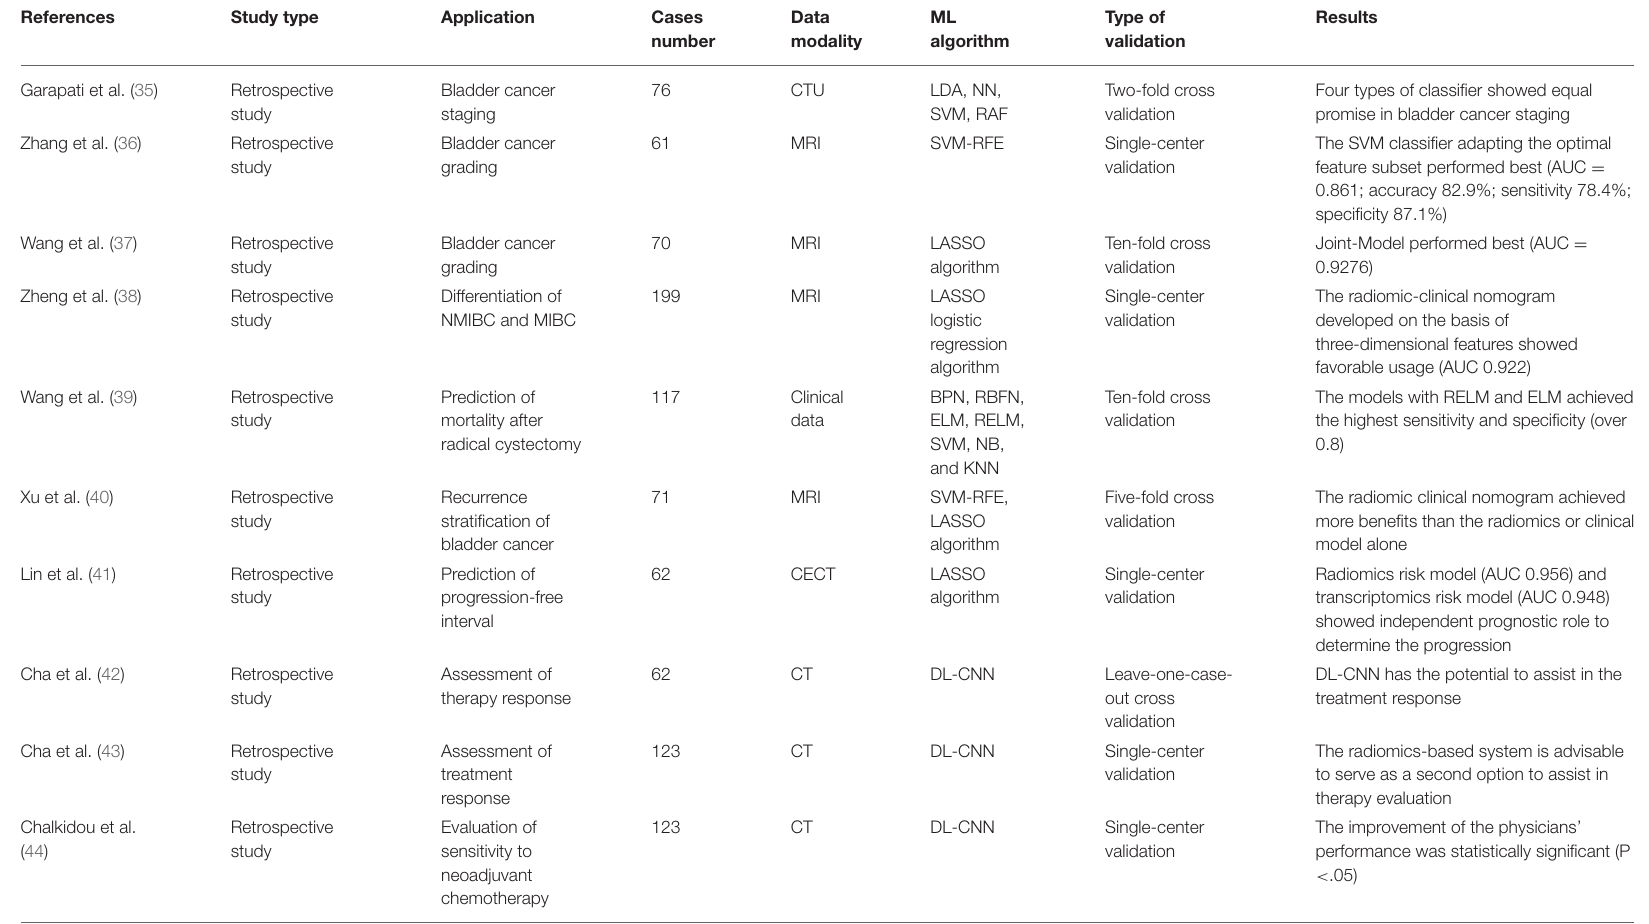
TABLE 1 | Present studies that combined radiomics and machine learning (ML) in bladder